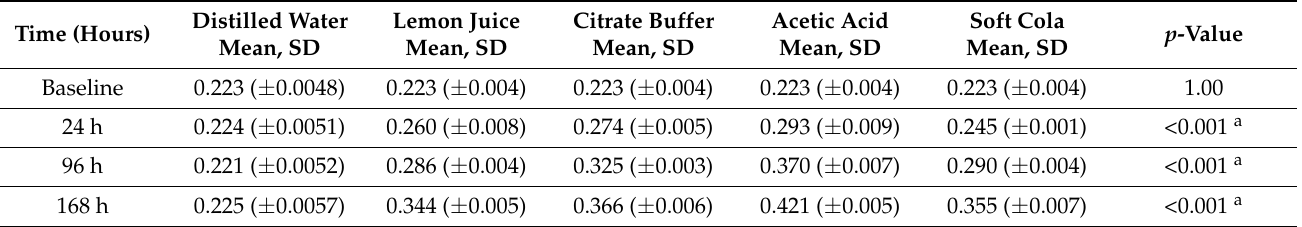
Table 4. Comparison of surface roughness (mean Ra value) of nano-fluorapatite ceramic between five immersion media at different time